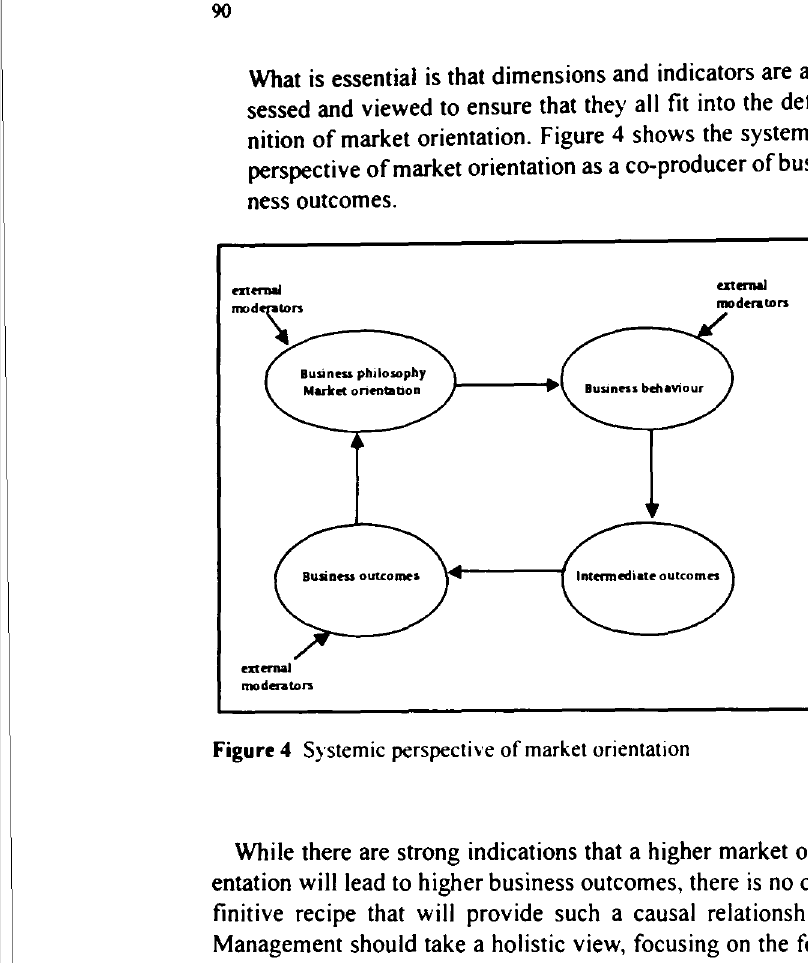
While there are strong indications that a higher market ori entation will lead to higher business outcomes, there is no de finitive recipe that will provide such a causal